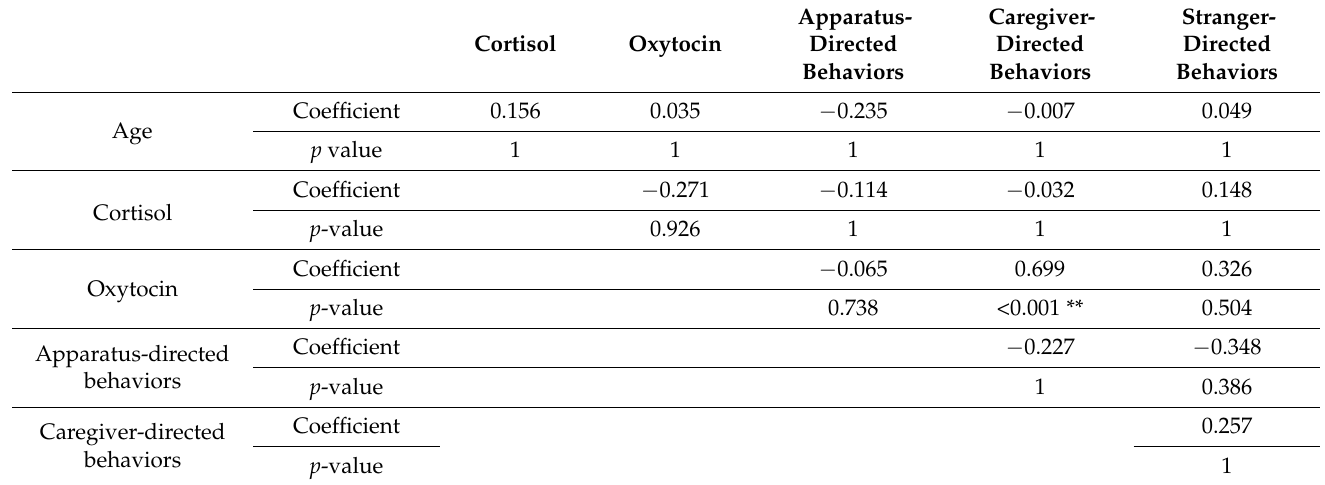
Table 2. Spearman correlations between oxytocin, cortisol, and behavioral variables (duration). Asterisks indicate a significant correlation. Sample size: 29 cows.